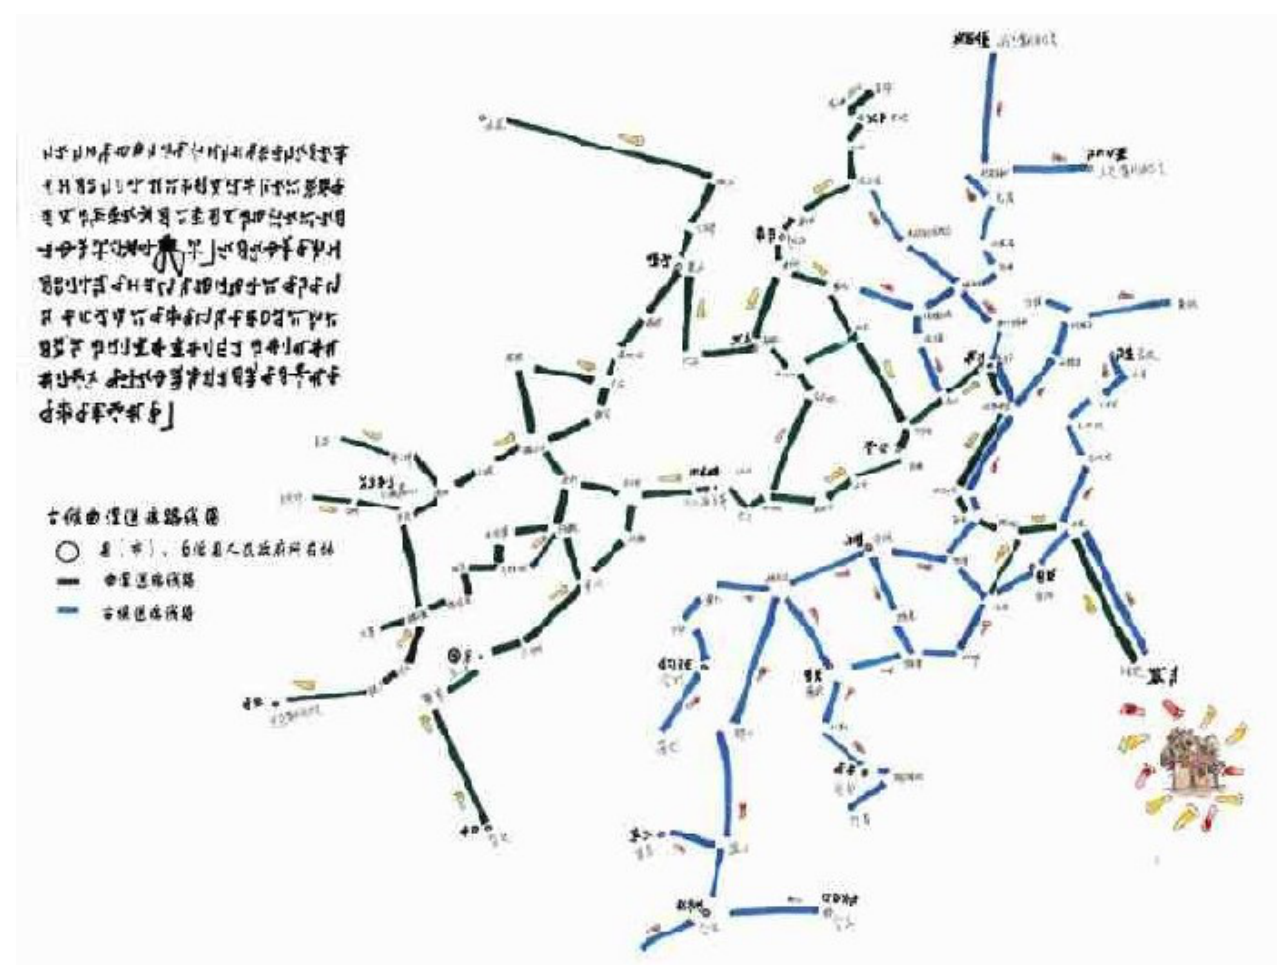
Fig. 5. The Yi genealogical tree can be traced back 80 generations. Each generation links to a particular place and time on the map of historical Yi migration routes from their origins in Zhaotong, northeast Yunnan